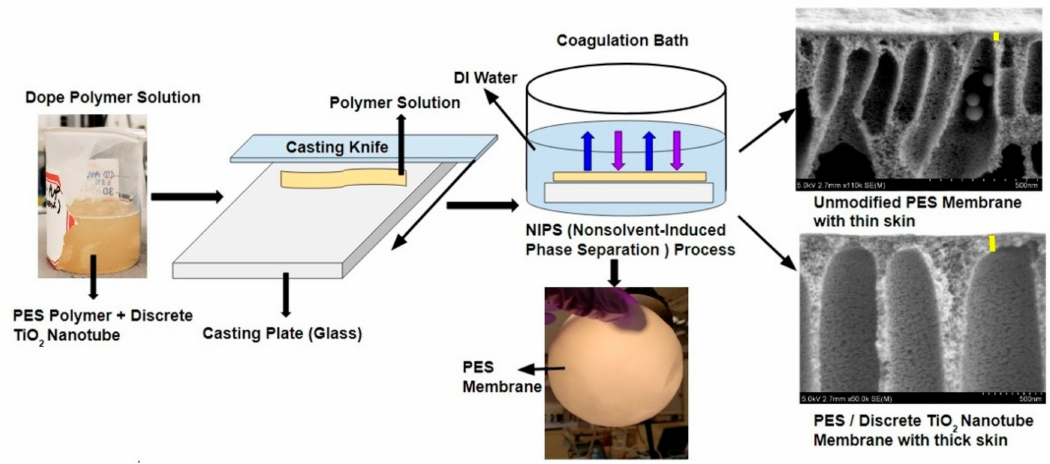
Figure 3. Fabrication process of TiO 2 NTs / PES nanocomposite